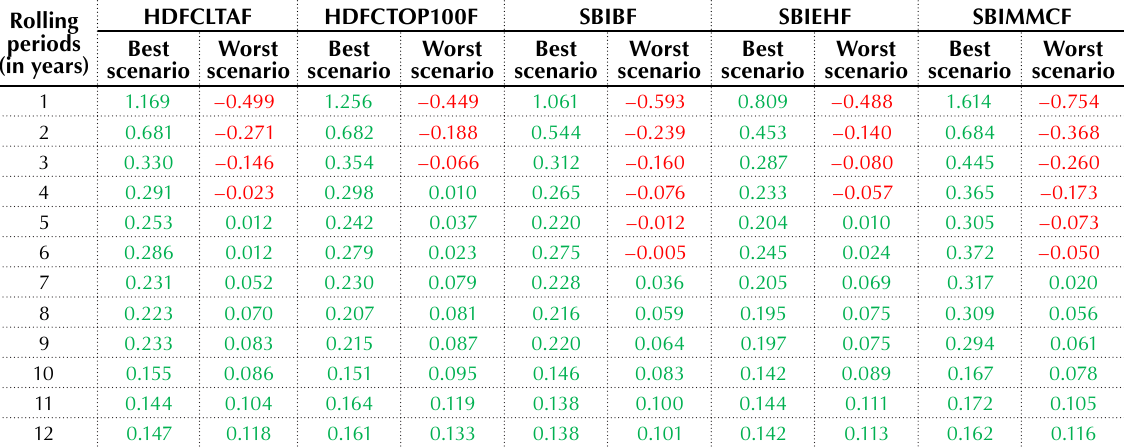
Table 8. Rolling period CAGR (in %) for HDFCLTAF, HDFCLTOP100F, SBIBF, SBIEHF, SBIMMCF schemes